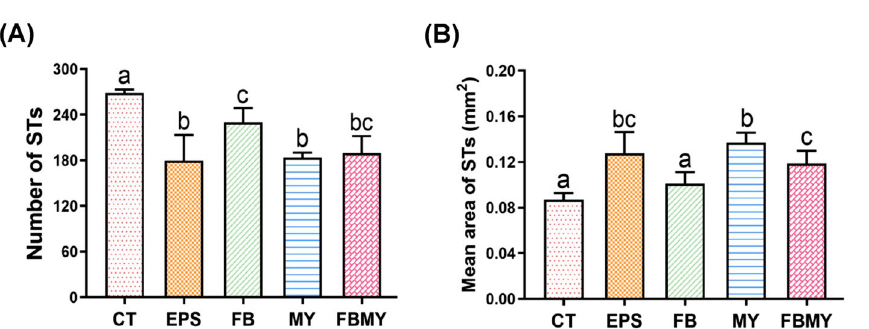
Figure 4. Effects of C. militaris fermentation products on the numbers (A) and mean area (B) of STs in testicular sections in different indicated groups. Values are presented as means ± SD (n = 5 for all test groups). Panels marked with different lowercase letters are significantly different ( p <